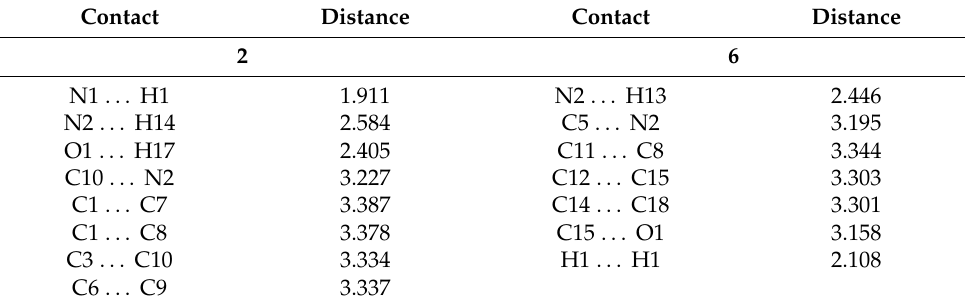
Figure 5. Hirshfeld maps of compounds 2 and 6 . The most important interactions are A) O…H, B) (B) N . . . H, (C) C . . . N, (D) C . . . C, (E) C . . . O, and (F) H . . . H. Table 5. Short contacts in compounds 2 and 6 . Table 5. Short contacts in compounds 2 and 6